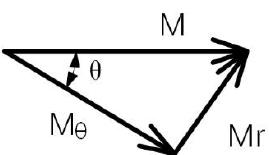
Figure 6. Geometric relationship of magnetization components.